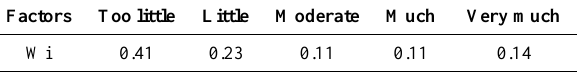
Table 7 . Weighting using a normalized matrix.